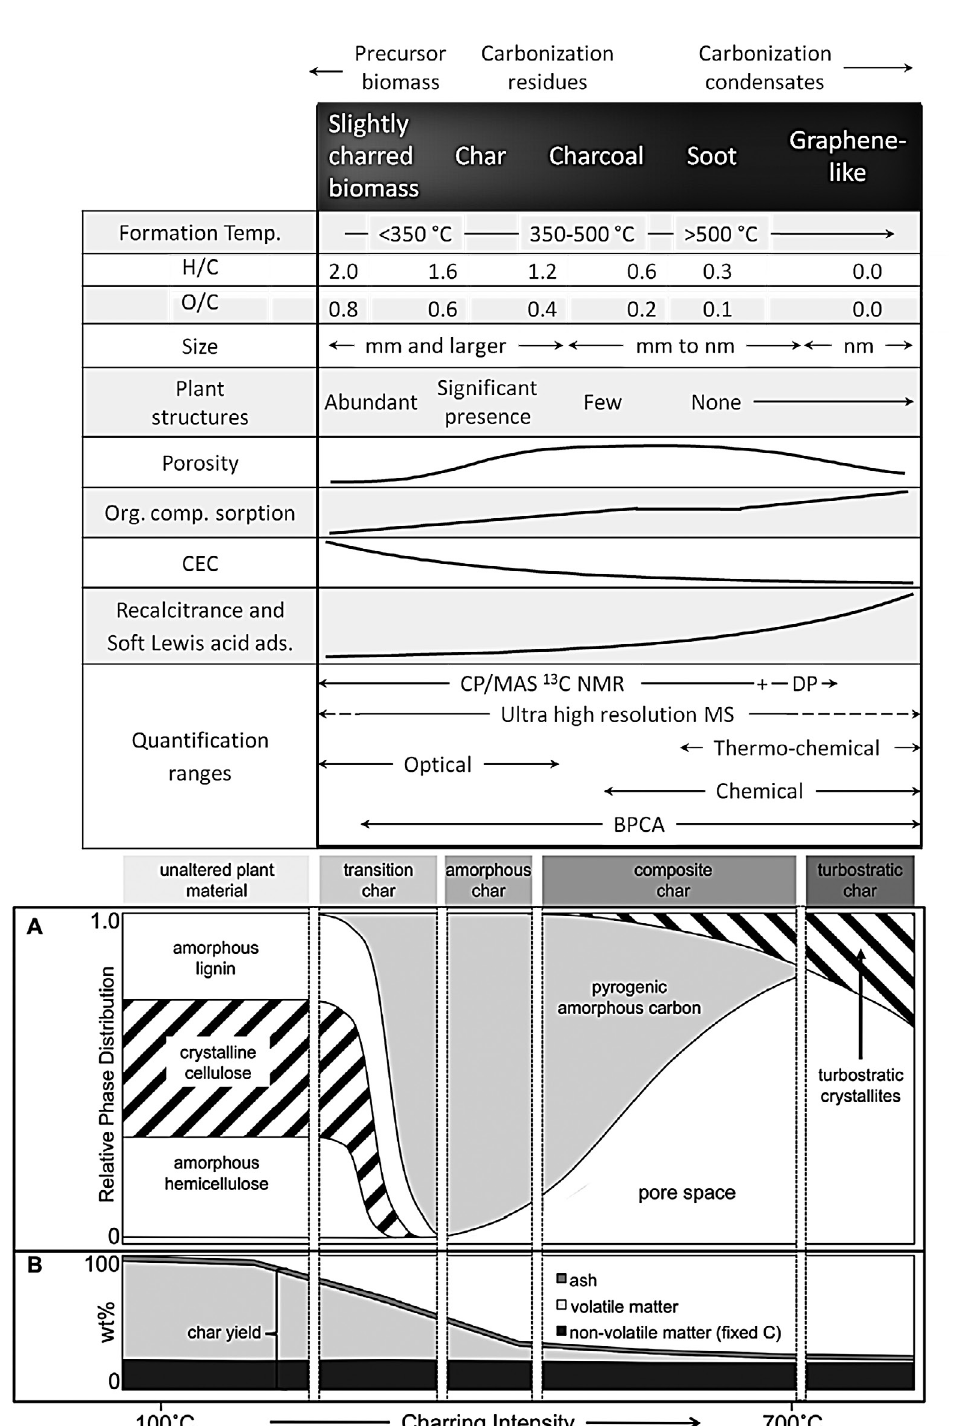
Figure 3. Model of carbonization continuum and associated key properties and functions. Formation Temp.: peak heat treatment temperature; H/C and O/C: atomic ratios; Org. comp. sorption: sorption capacity for polar and nonpolar compounds; CEC: cation exchange capacity; Soft Lewis acid ads.: adsorption capacity for soft Lewis acids (e.g. some heavy metals such as Hg 2+ , Hg 2+ 2 , Cd 2+ ); CP/MAS 13 C NMR: cross polarization by carbon-13 nuclear magnetic resonance with magic angle sample spinning, DP: direct polarization MAS 13 C NMR, the quantification range of DP covers a broader range than CP; BPCA: benzene polycarboxilic acids (carbonization molecular markers) analysis. Source: Adapted from Hedges et al. (2000), Masiello (2004), Hammes et al. (2007), Bird and Ascough (2012). Bottom figure (a and b), source: Keiluweit et al. (2010) Reprinted. Copyright © (2010) American Chemical